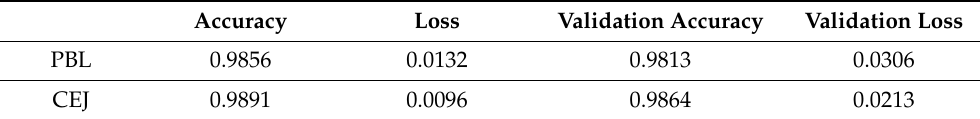
Figure 5. Accuracy of the CEJ boundary detection model. Table 1. Predictive accuracy and loss of PBL and CEJ using U-Net.